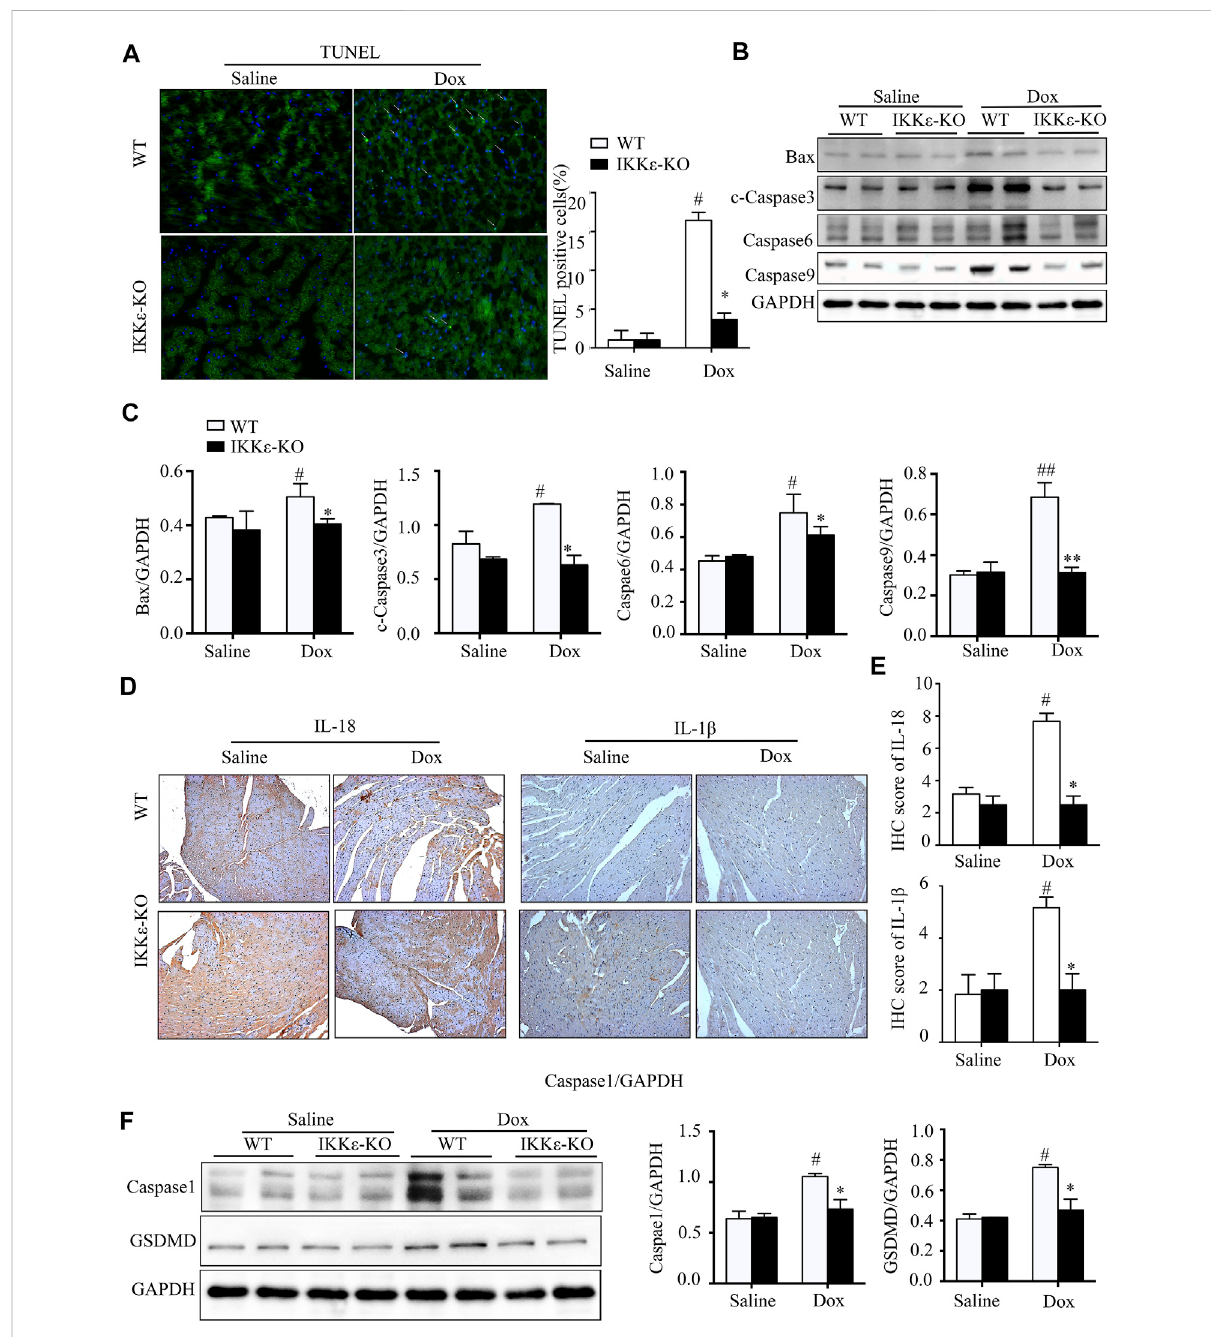
FIGURE 4 IKK ε knockout ameliorated pyroptosis and apoptosis in myocardial tissue after Dox stimulation. (A) . Representative fi gures and analysis of TUNELstainingoftissuefromWTandIKK ε -KOmiceafterDoxinjection( n =4miceperexperimentalgroup,vs.SalineorWTDox, # p /* p < 0.05). (B,C) . Thewesternblottingimagesandanalysisofapoptosis-related proteinsinthehearttissueofWTandIKK ε -KOmiceinjectedwithDoxfor30 days( n = 4 mice per experimental group, vs. Saline or WT Dox, # p /* p < 0.05). (D,E) . Representative Immunohistochemistry images and analysis of IL-18 and IL-1 β in the heart tissues of WT and IKK ε -KO mice after Dox injection ( n = 4 mice per experimental group, 200x, vs. Saline or WT Dox, # p /* p < 0.05). (F) . Representative western blot images and analysis of proteins associated with pyroptosis in heart tissue of WT and IKK ε -KO mice injected with Dox for 30 days ( n = 4 mice per experimental group, vs. Saline or WT Dox, # p /* p <